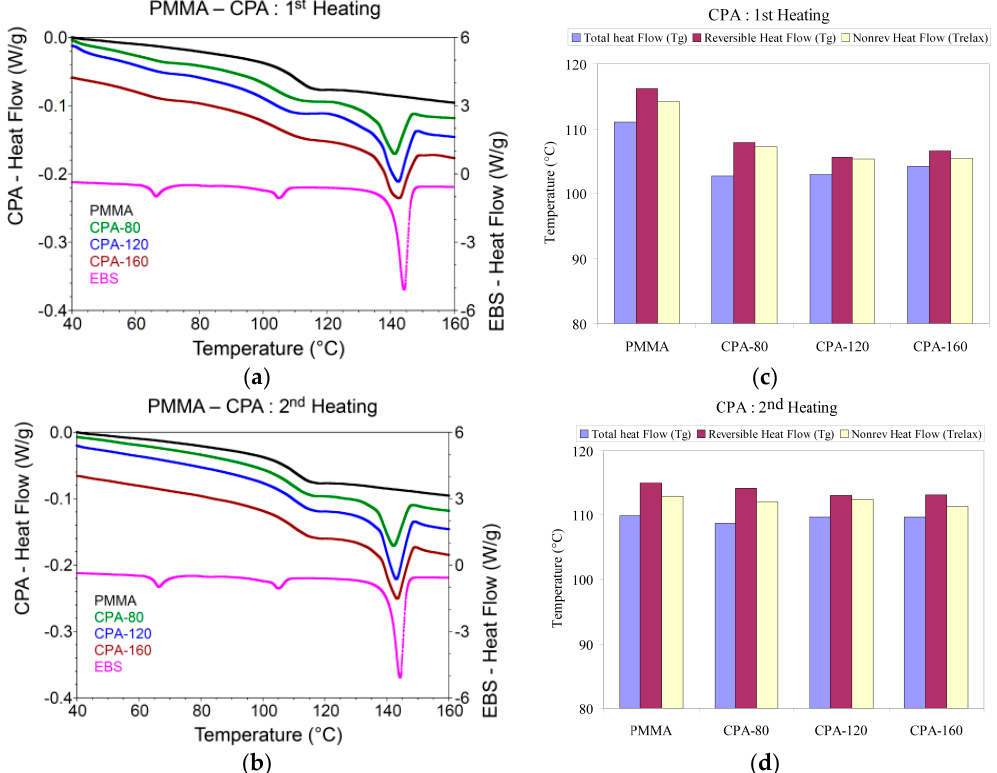
Figure 4. PMMA chain transition ( T g , T relax ) in the HNT–EBS masterbatches. DSC thermograms: ( a ) the 1st heating and ( b ) the 2nd heating). T g (from the Total and Reversible Heat Flow) and T relax (from the Non-Reversible Heat Flow): ( c ) the 1st heating and ( d ) the 2nd heating).